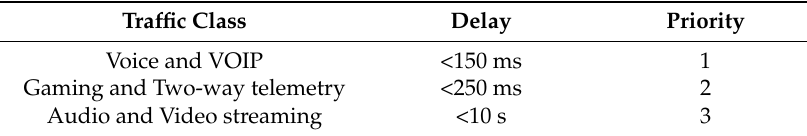
Table 1. Delay for each priority group (© 2016 IEEE).